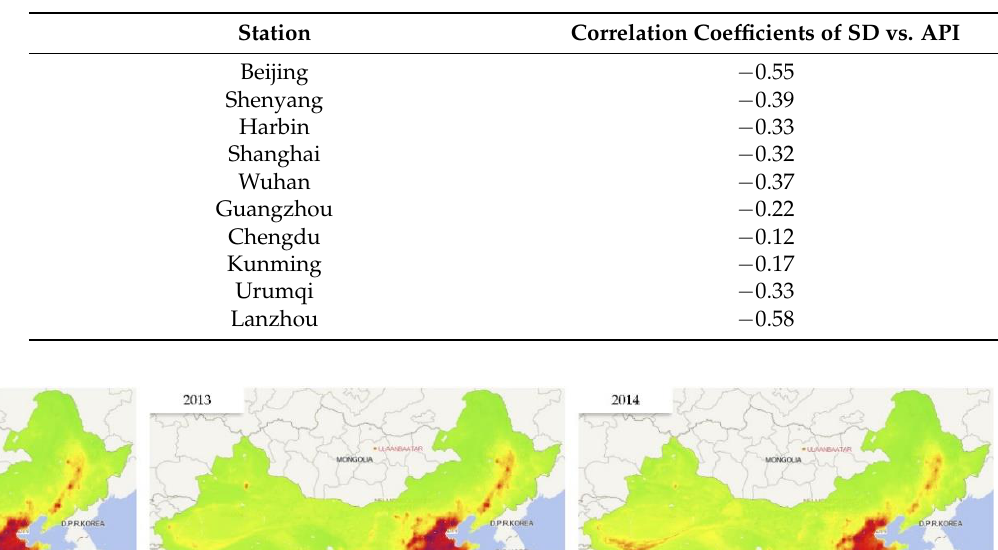
Table 3. The correlation coefficients between SD and API.